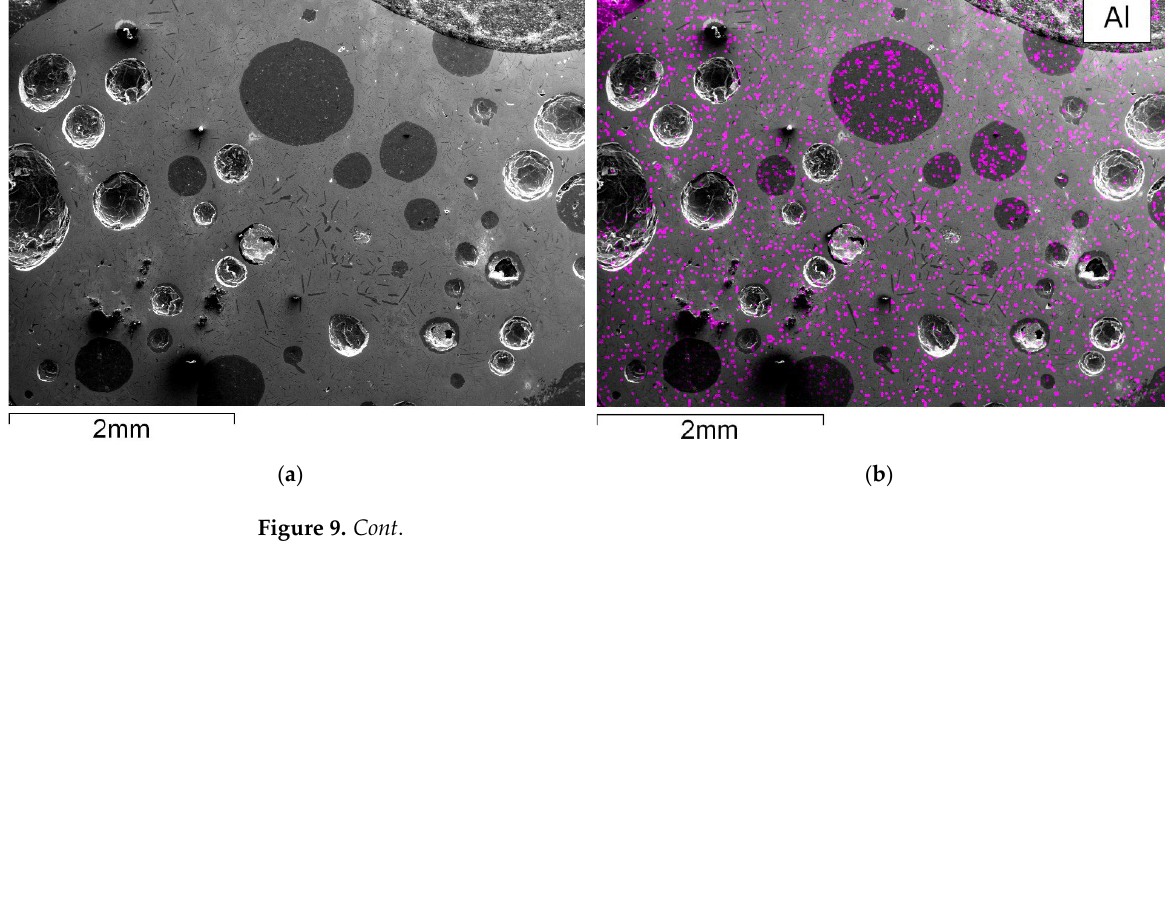
Figure 8. SEM-secondary electron images of cut and polished specimens of the metal-fraction em- bedded in epoxy resin: ( a ) metal droplet with blowholes and elongated graphite crystallite; ( b ) metal droplet with holes and spherical inclusions.